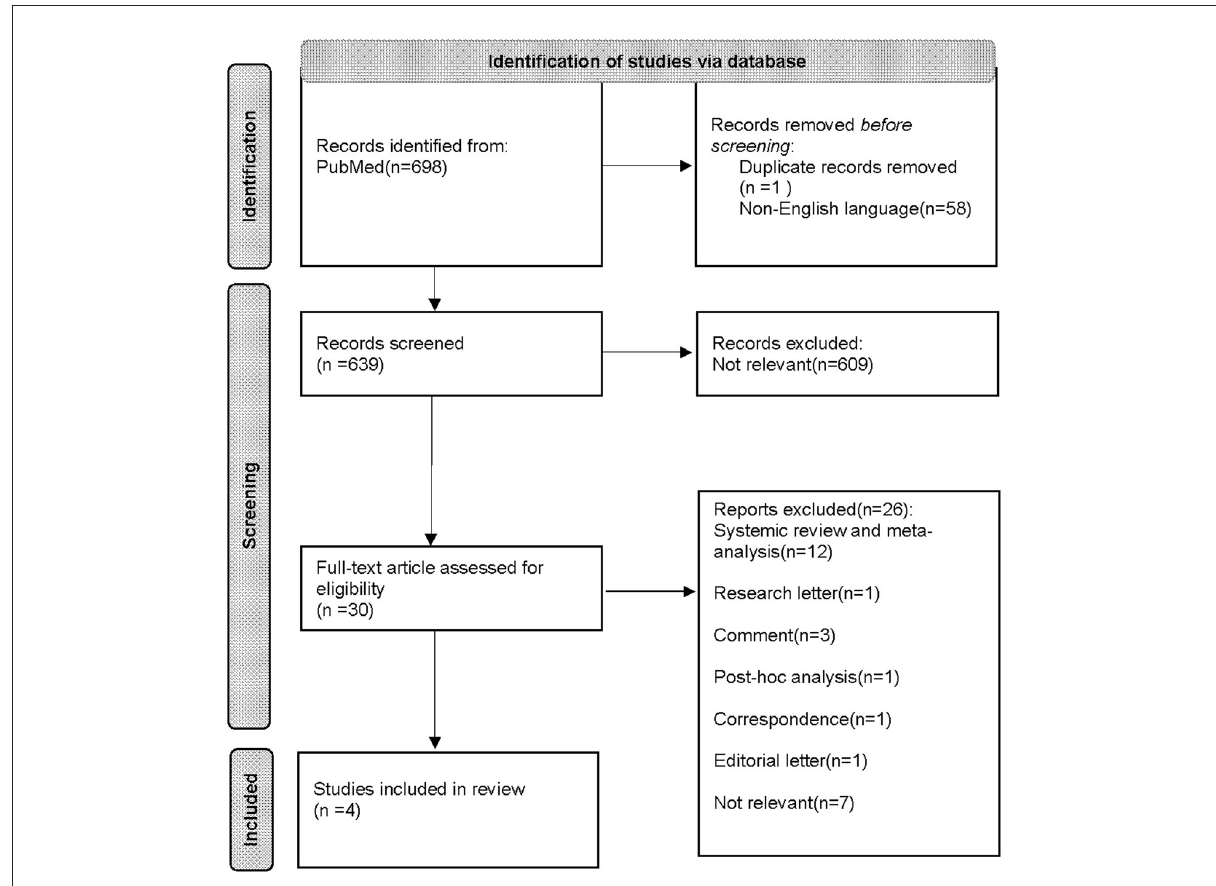
FIGURE1 PRISMA flow diagram that summarizes the literature search